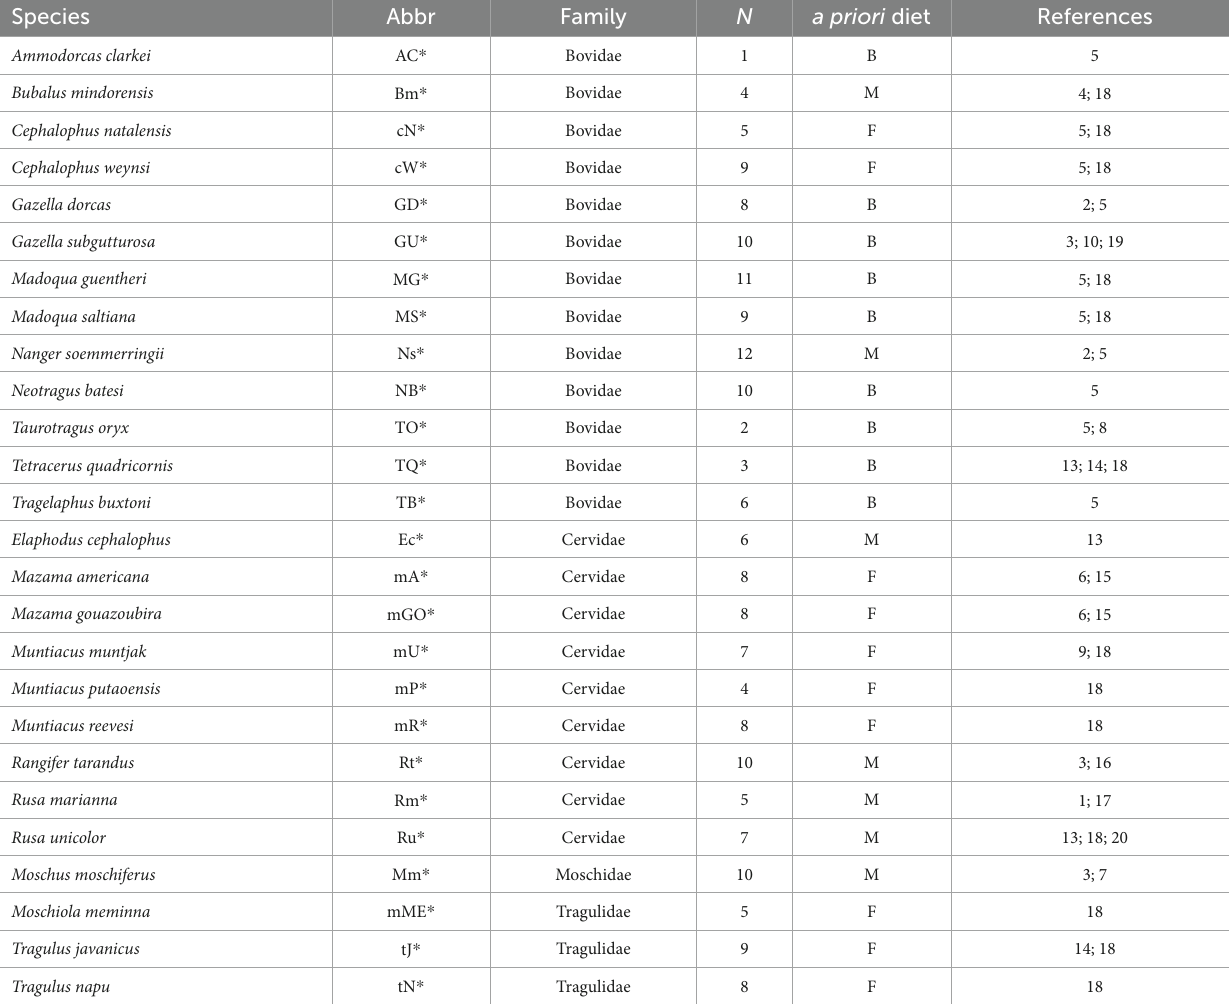
TABLE 2 Species with questionable a priori dietary assignments derived from the literature.